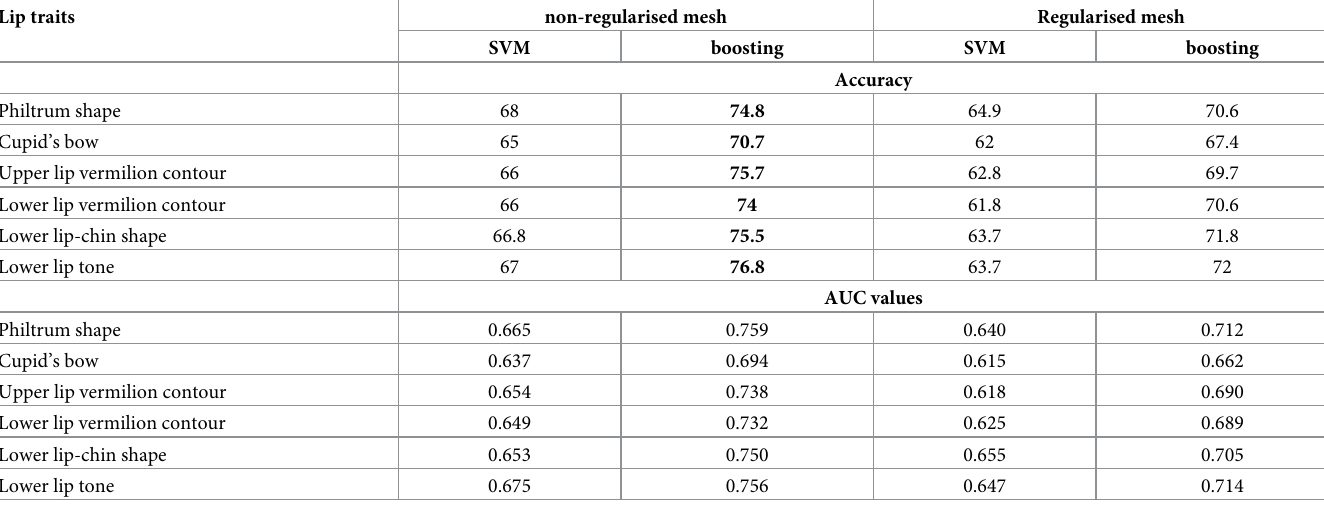
Table 5. Classification results based on geodesic path